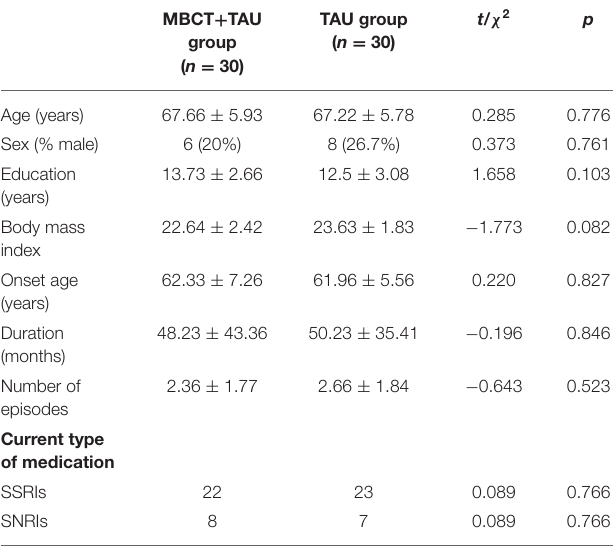
TABLE 1 | Demographic and clinical characteristics of the